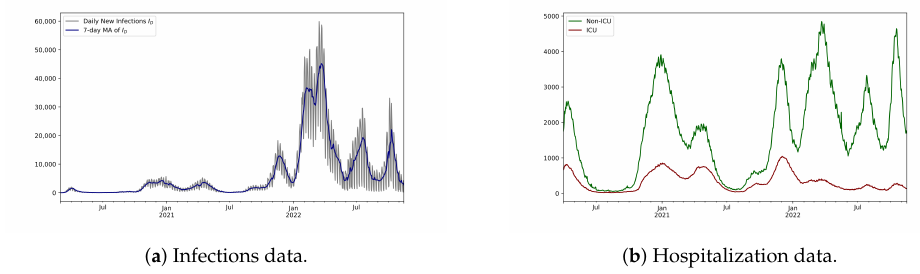
Figure 3. Time series of infections and hospitalisation data. ( a ) The grey line indicates the new infections, as reported by the RKI. The blue line indicates the 7-day moving average of the new infections. ( b ) The green line indicates the hospitalised COVID-19 patients in non-ICU on any given date, whereas the red line indicates the hospitalised COVID-19 patients in the